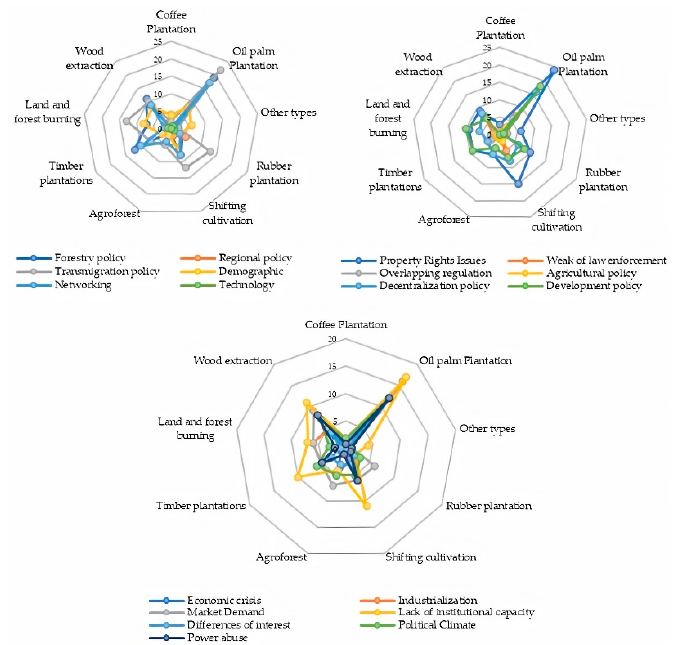
Figure 7. Radar charts for the combination of direct causes and underlying causes in land-use change. (The numbers in the charts indicate the studies of combination direct causes and underlying causes cited).